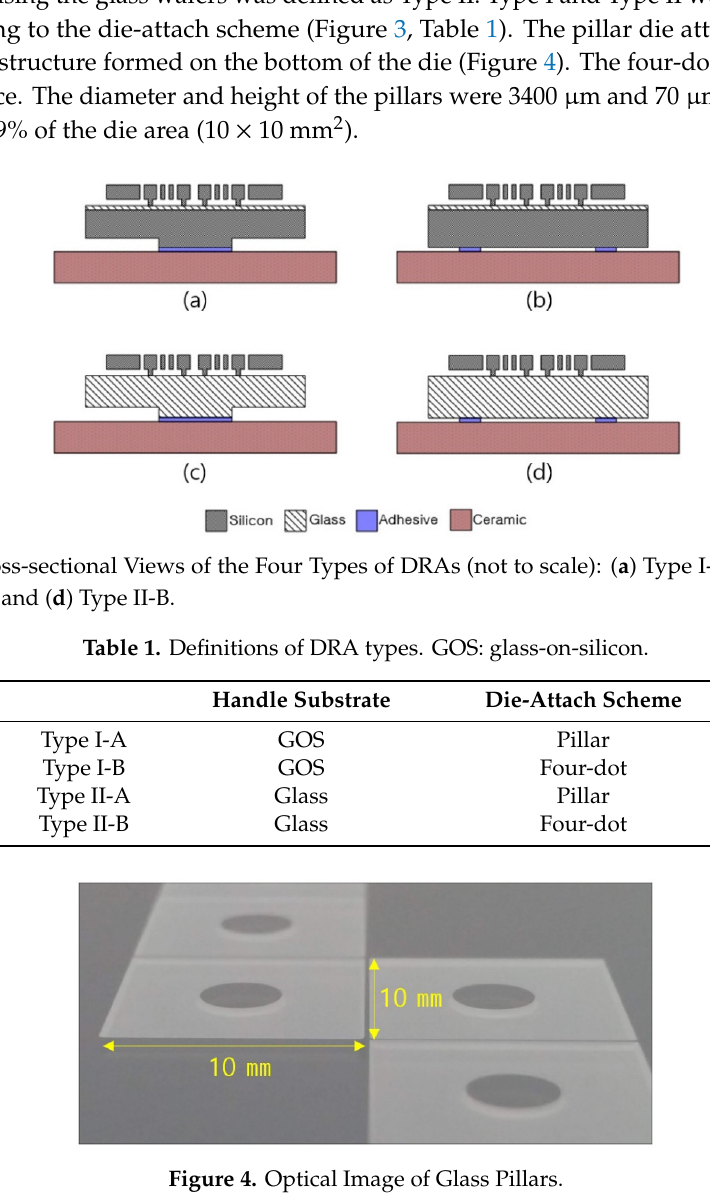
Figure 4. Optical Image of Glass Pillars.